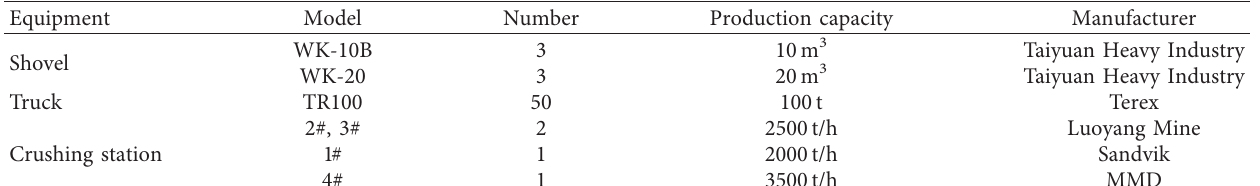
Table 1: Equipment information of mining semicontinuous system in Baorixile open-pit mine.